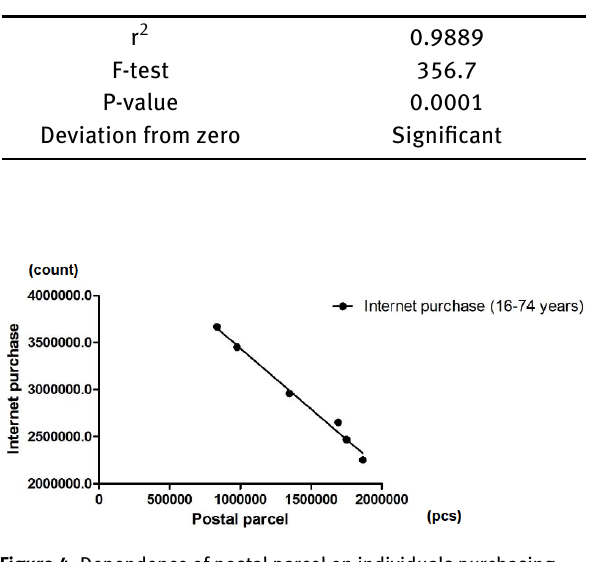
Figure 4: Dependence of postal parcel on individuals purchasing over the Internet (16-74 years).